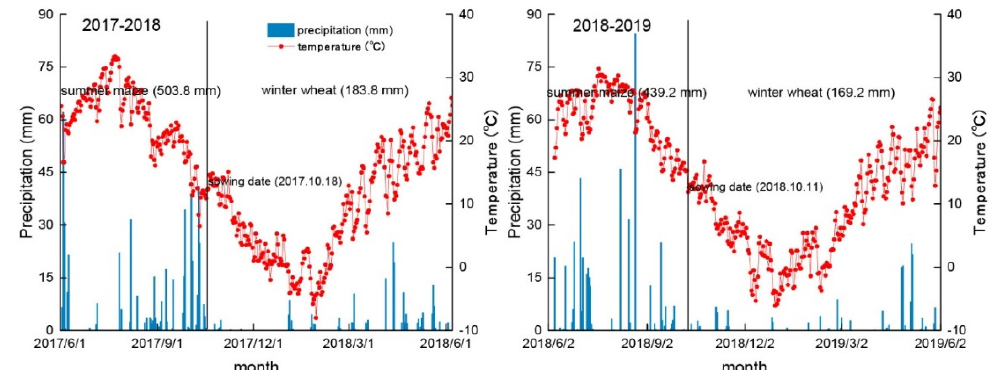
Figure 1. The daily mean temperature and precipitation during the study period in 2017–2019.